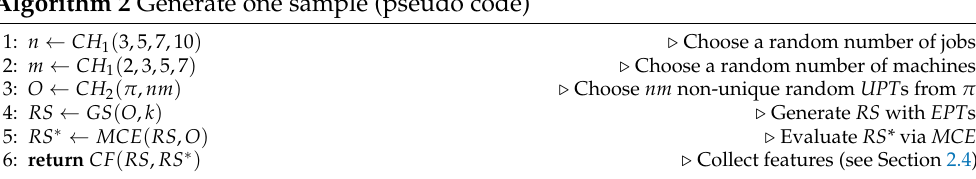
Algorithm 2 Generate one sample (pseudo